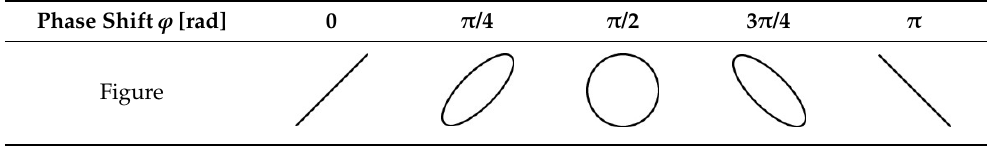
Table 2. Lissajous curves for ω x = ω y and X = Y . Phase Shift ϕ [rad]